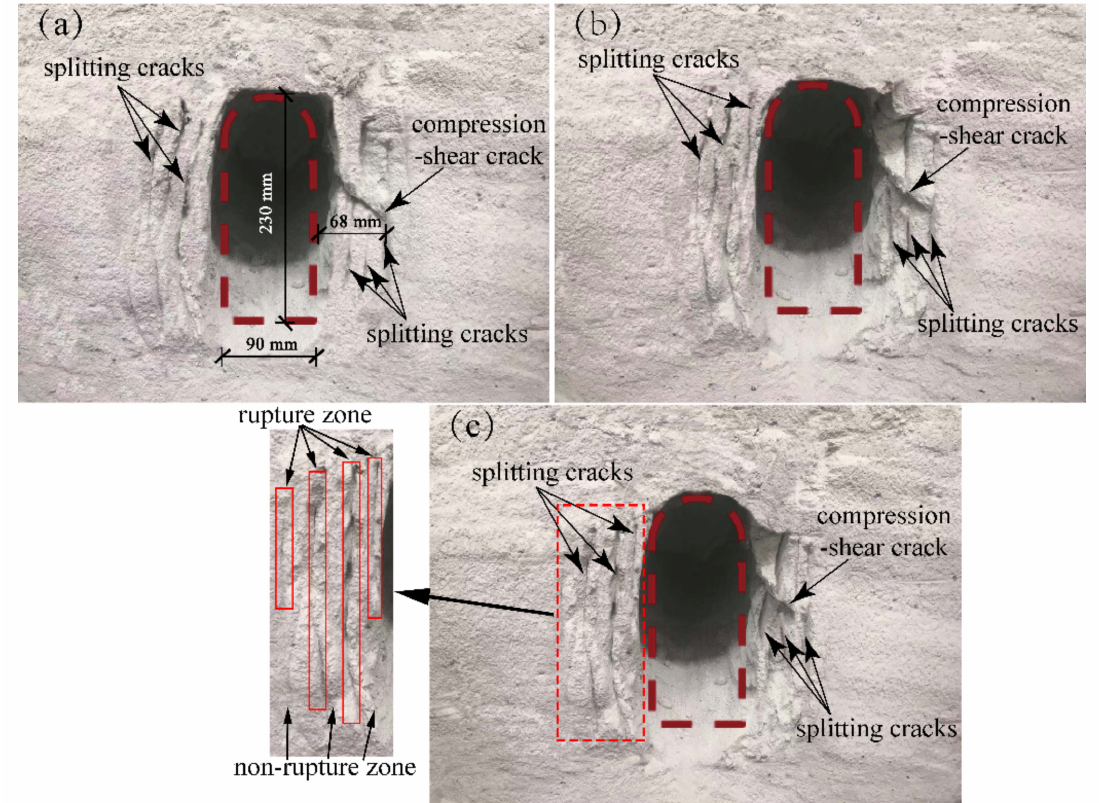
Figure 9. The fracture mode of the splitting failure model test of the high sidewall cavern. ( a ) 100 mm from the front boundary of the model; ( b ) 200 mm from the front boundary of the model; ( c ) 300 mm from the front boundary of the model